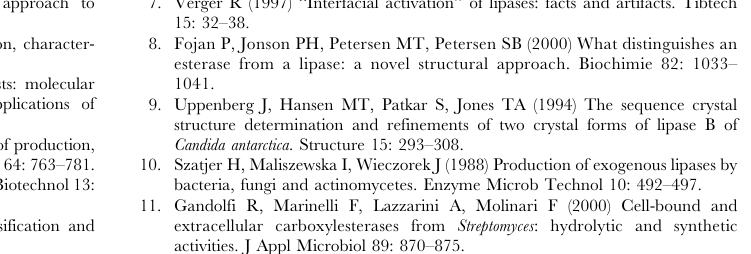
Figure S1 Specific activities of EstB and EstC toward p NP-C5 at different temperatures. (TIF) Table S1 Primers employed for amplification of ORFs coding for putative non-secreted lipolytic enzymes of S.